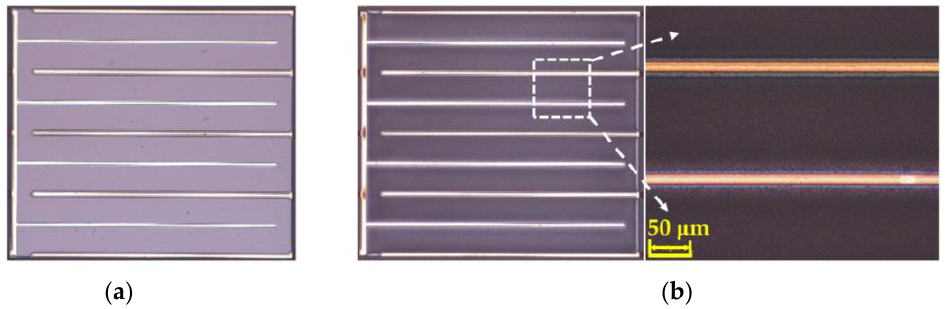
Figure 2. Si 3 N 4 -passivated LEDs with ( a ) a flat surface and with ( b ) a rough surface.